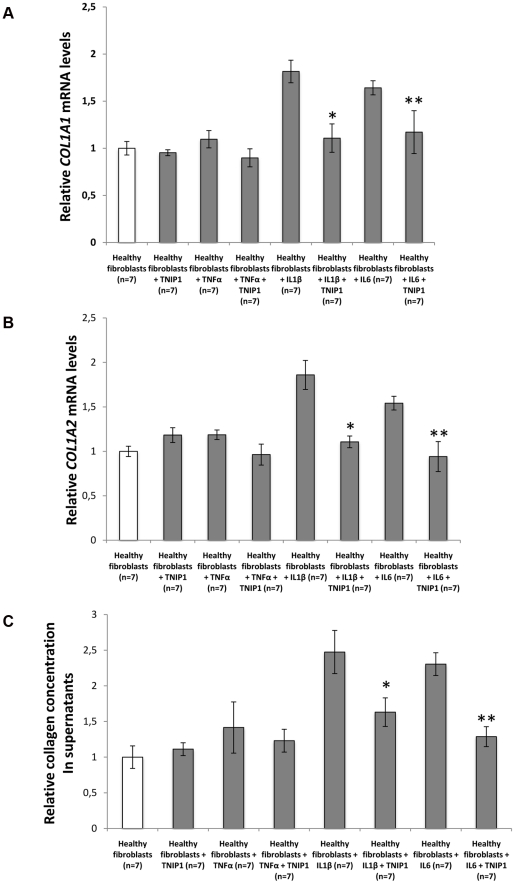
TNIP1 abrogates the profibrotic effects of proinflammatory cytokines on collagen synthesis by healthy fibroblatsts.(A,B) Healthy dermal fibroblasts treated with recombinant Il1β or Il6 and incubated 24 hours with TNIP1 displayed decreased mRNA levels for (A) COL1A1 (1.6 and 1.4-fold reduction, P = 0.01 and 0.03, respectively) and (B) COL1A2 (1.7 and 1.6-fold reduction, P = 0.02 and 0.03, respectively). No significant effect was observed in cells treated with recombinant TNFα. (C) Collagen content in cell culture supernatants treated with Il1β or Il6 was also reduced upon treatment with TNIP1 (1.5 and 1.8-fold reduction, P = 0.02 and 0.03, respectively). * indicates a P<0.05 versus healthy control fibroblasts treated with recombinant IL1β. ** indicates a P<0.05 versus healthy control fibroblasts treated with recombinant IL6.